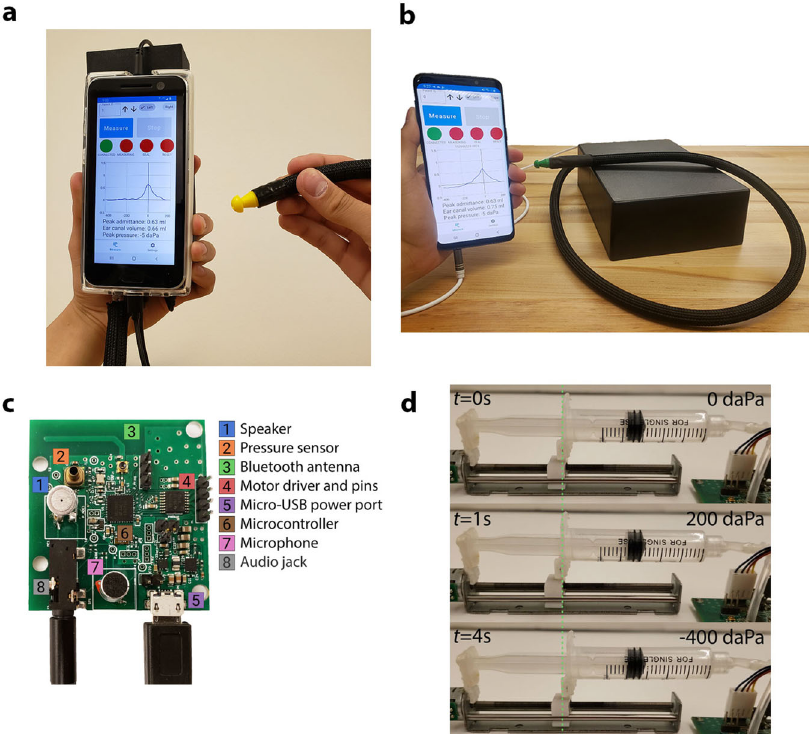
Fig. 1 Low-cost smartphone-based tympanometer. a All components of the hand-held tympanometer fi t into a portable 3D printed enclosure that attaches to the back of a smartphone. b A desktop version of our tympanometer. c Close-up of PCB containing the key acoustic and pressure sensing elements of the tympanometer. The PCB includes a microcontroller, Bluetooth antenna and micro-USB port for computing, communication, and power respectively. d Through precise movements of a plunger and syringe, the stepper motor introduces positive and negative pressure into the ear canal. The green line is a reference marker for the plunger location at the beginning of the measurement. The plunger moves 5.3 mm to perform the pressure sweep from 200 to − 400